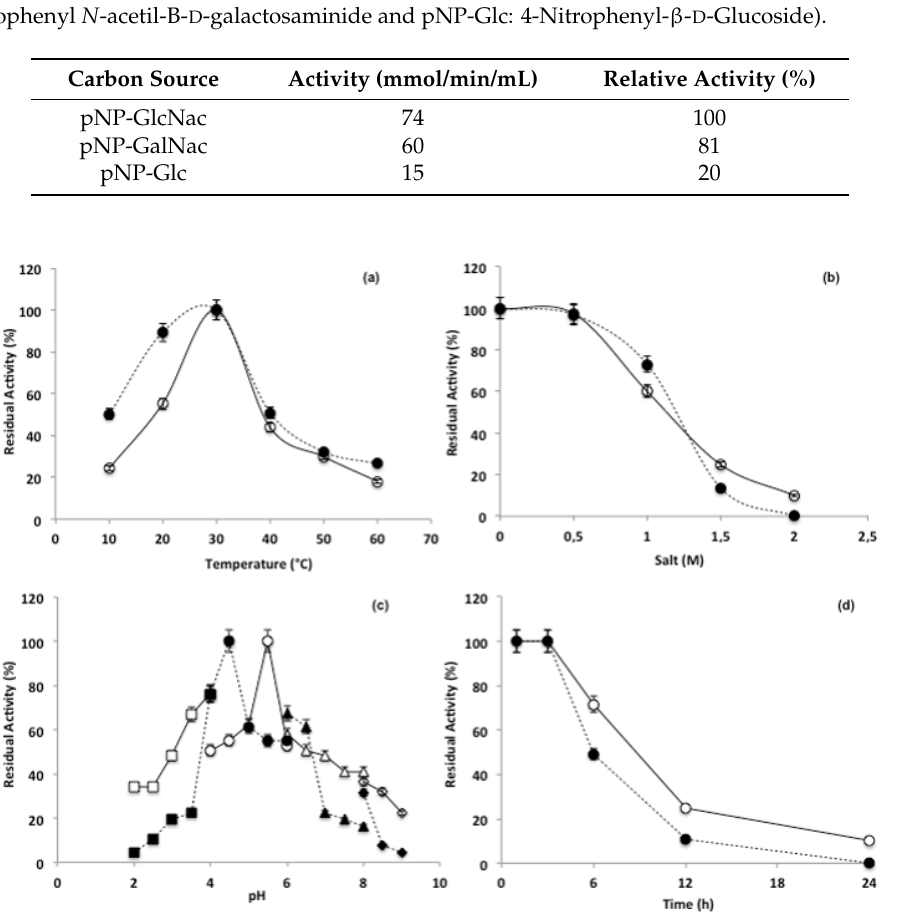
Table 1. Activity variation of the distinct substrates tested. The activity is reported as mmol/min/ml in relation to the final percentage. (pNP-GlcNac: 4-nitrophenyl N -acetyl-B- D -glucosaminide; pNP-GalNac: